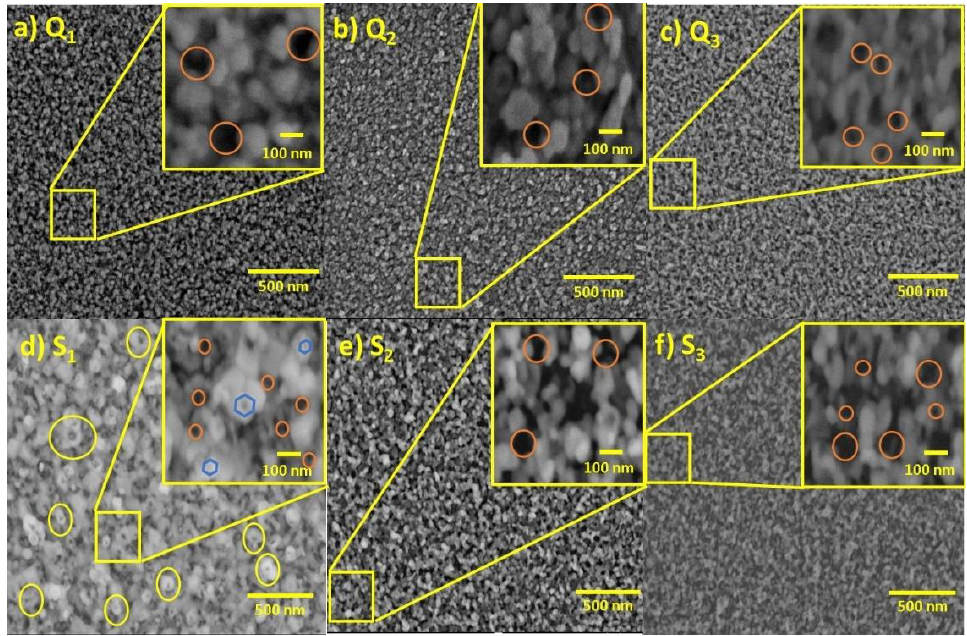
Figure 6. Comparison among the surfaces of the samples imaged with SEM after the precursor layer was processed at ( a ) 600, ( b ) 700, and ( c ) 800 °C on quartz substrates and processed at ( d ) 600, ( e ) 700, and ( f ) 800 °C on Si substrates. The inserts show magnified sections of the samples.